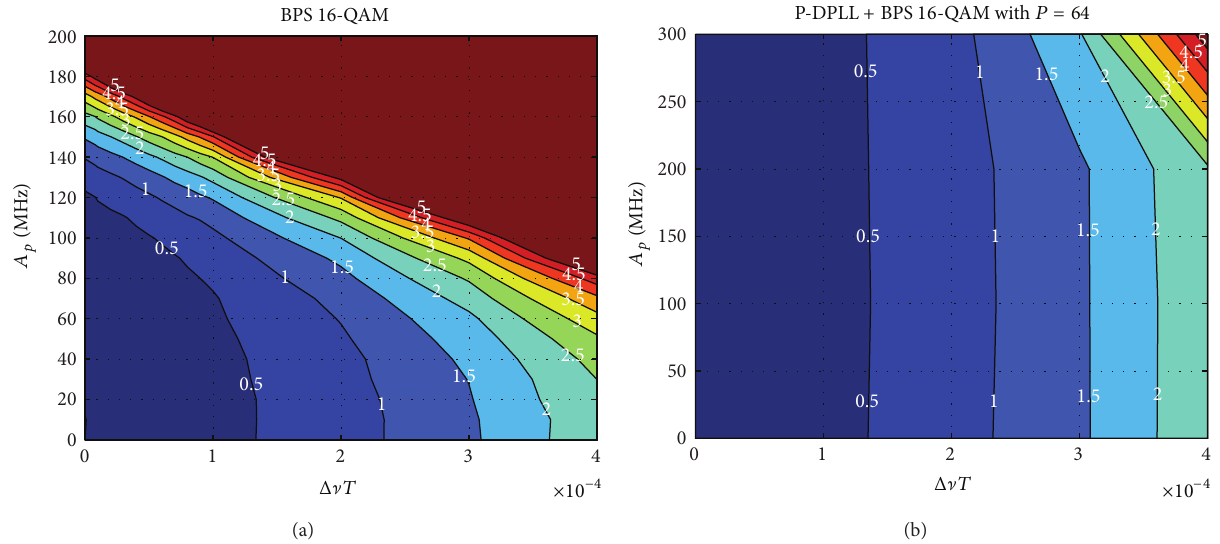
Figure 18: Surface of performance of the treated CPR algorithms under the joint effect of laser phase noise and frequency fluctuation. (a) BPS and (b) P-DPLL + BPS schemes with Δ𝑓 𝑐 = 35 kHz, 1/𝑇 = 32 Gs/s, 𝑃 = 64 , 𝑁 = 21 , and 𝐵 = 32 .